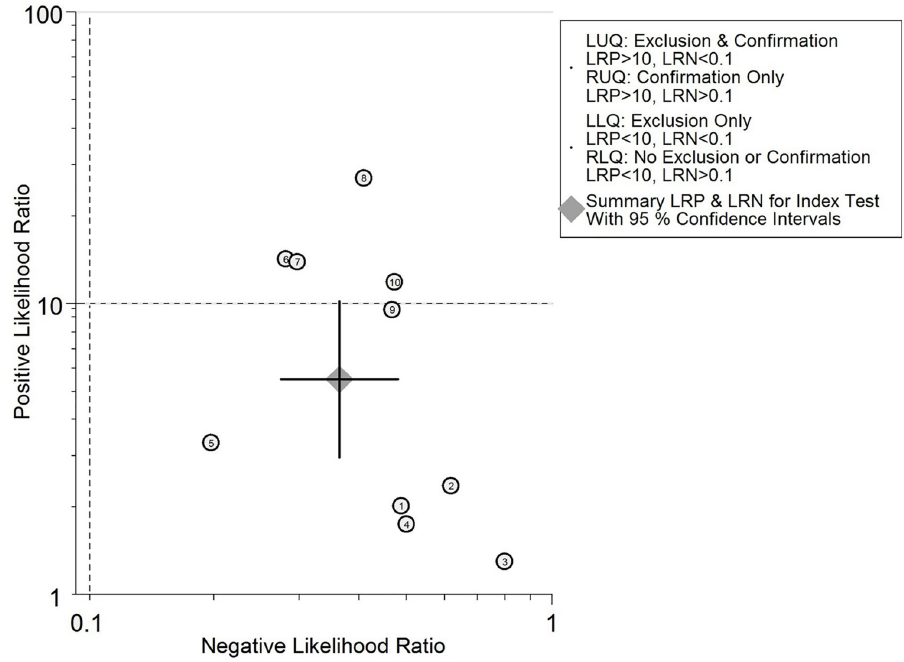
Fig 7. Likelihood matrix for the overall distribution of the studies. Each point corresponds to a study. None of the included studies were found on the bottom left side of the matrix, which shows that they report reasonable sensitivity.